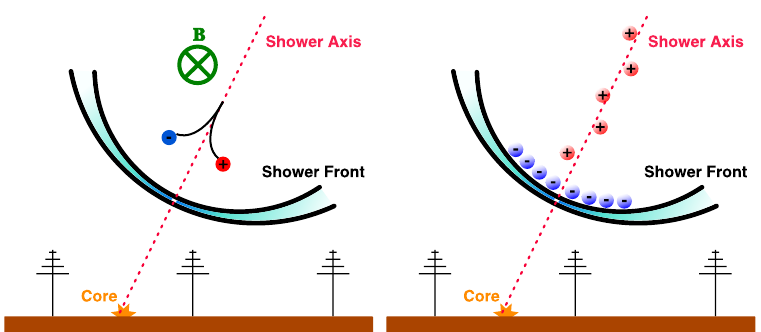
Figure 4: Schematic overview of radio emission mechanisms [ 28 ] . Left: The geo- magnetic mechanism. Right: The charge excess mechanism.